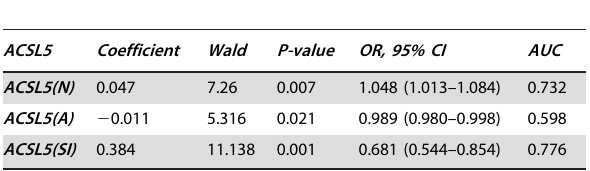
Table 2. Logistic regression analysis to determine the effect on diseases and the area under curve (AUC) of ACSL5 values in